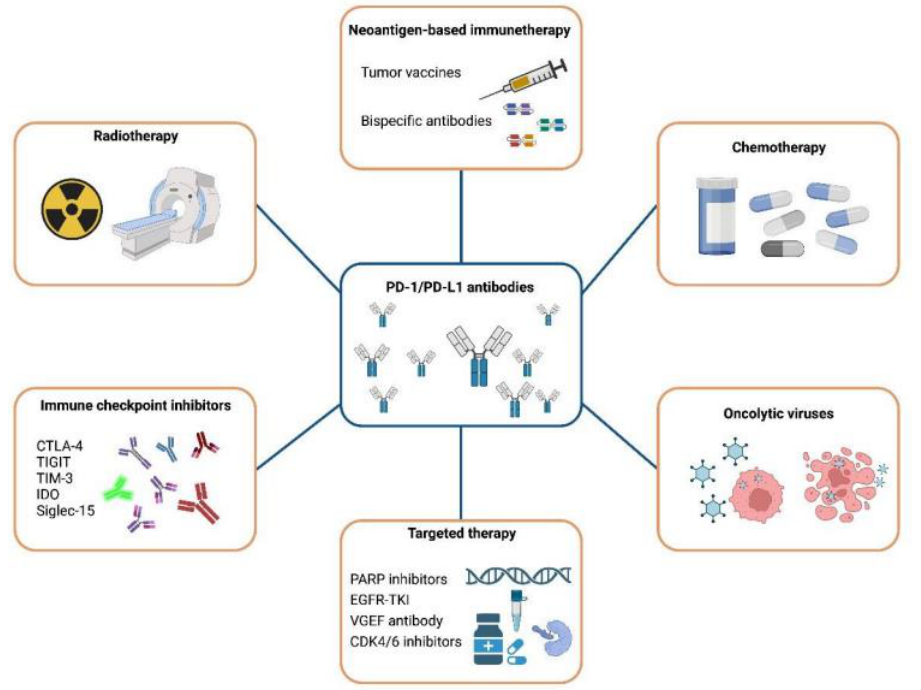
Figure 6. Combination therapies with anti-PD-1/PD-L1 antibodies. Combination therapies: including PD-1/PD-L1 antibodies along with radiotherapy, chemotherapy, other immune checkpoint antibodies, targeted therapy, oncolytic viruses and neoantigen-based immunotherapy are being developed to treat cancer patients effectively. Abbreviations: PD-1, Programmed cell death-1; PD-L1, Programmed cell death-ligand-1; CTLA-4, Cytotoxic T Lymphocyte-Associated Antigen-4; TIGIT, T cell immunoglobulin and ITIM domains; ITIM, immunoreceptor tyrosine-based inhibitory motif; TIM-3, T cell immunoglobulin domain and mucin domain-3; IDO, indoleamine 2, 3 dioxygenase; Siglec-15, Sialic Acid Binding Ig Like Lectin-15; PPAP inhibitors, Poly ADP-ribosepolymerase inhibitor; EGFR-TKI, epidermal growth factor receptor-tyrosine kinase inhibitors; VEGF antibody, vascular endothelial growth factor antibody; CKD4/6 inhibitors, cyclin dependent kinase4/6 inhibitors.